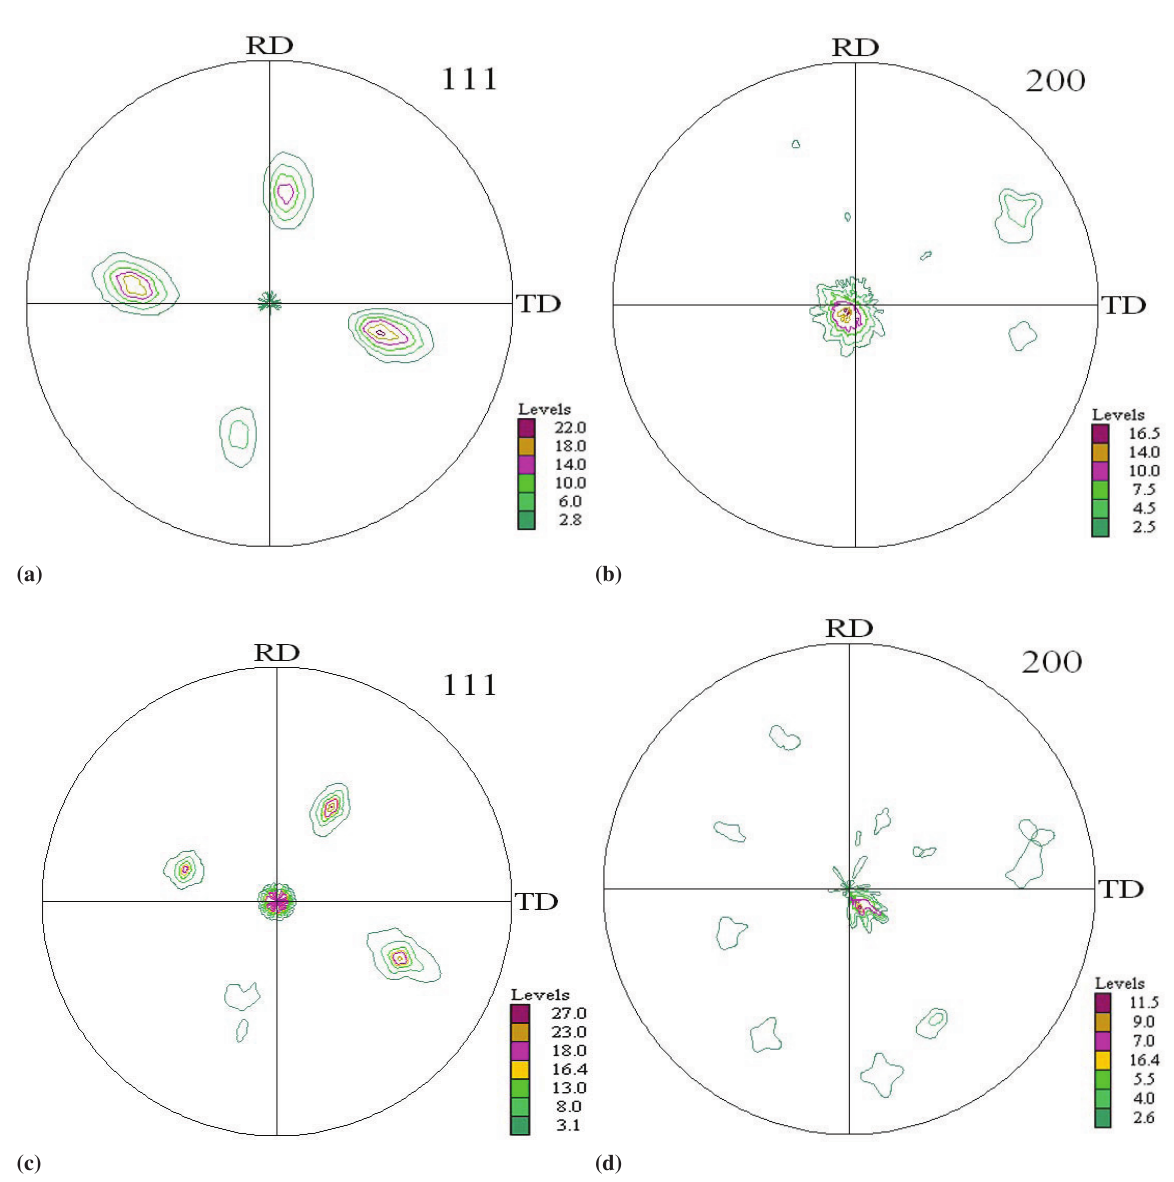
Figure 5. Pole figures for the 7YSZ coating deposited on a rotated sample with substrate pre-heating temperature of 950°C: (a–b) 10 rpm and (c–d) 20